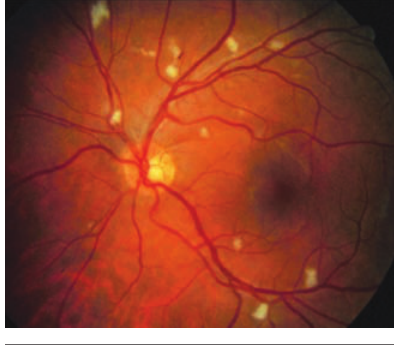
Figure 1. Several cotton wool spots, typical of HIV retinopathy, are seen in this